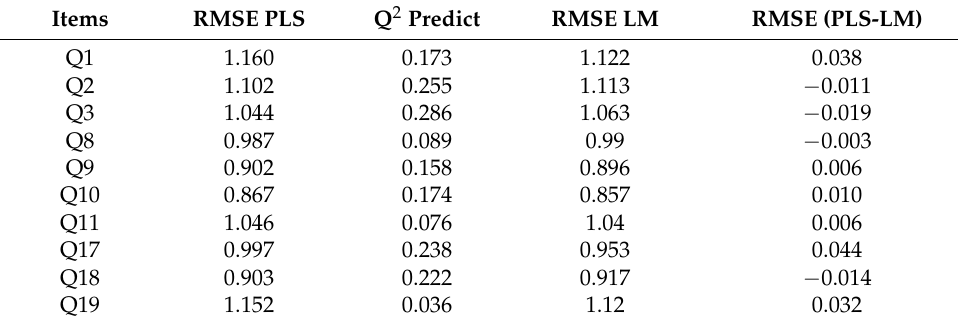
Table 5. PLS predict.